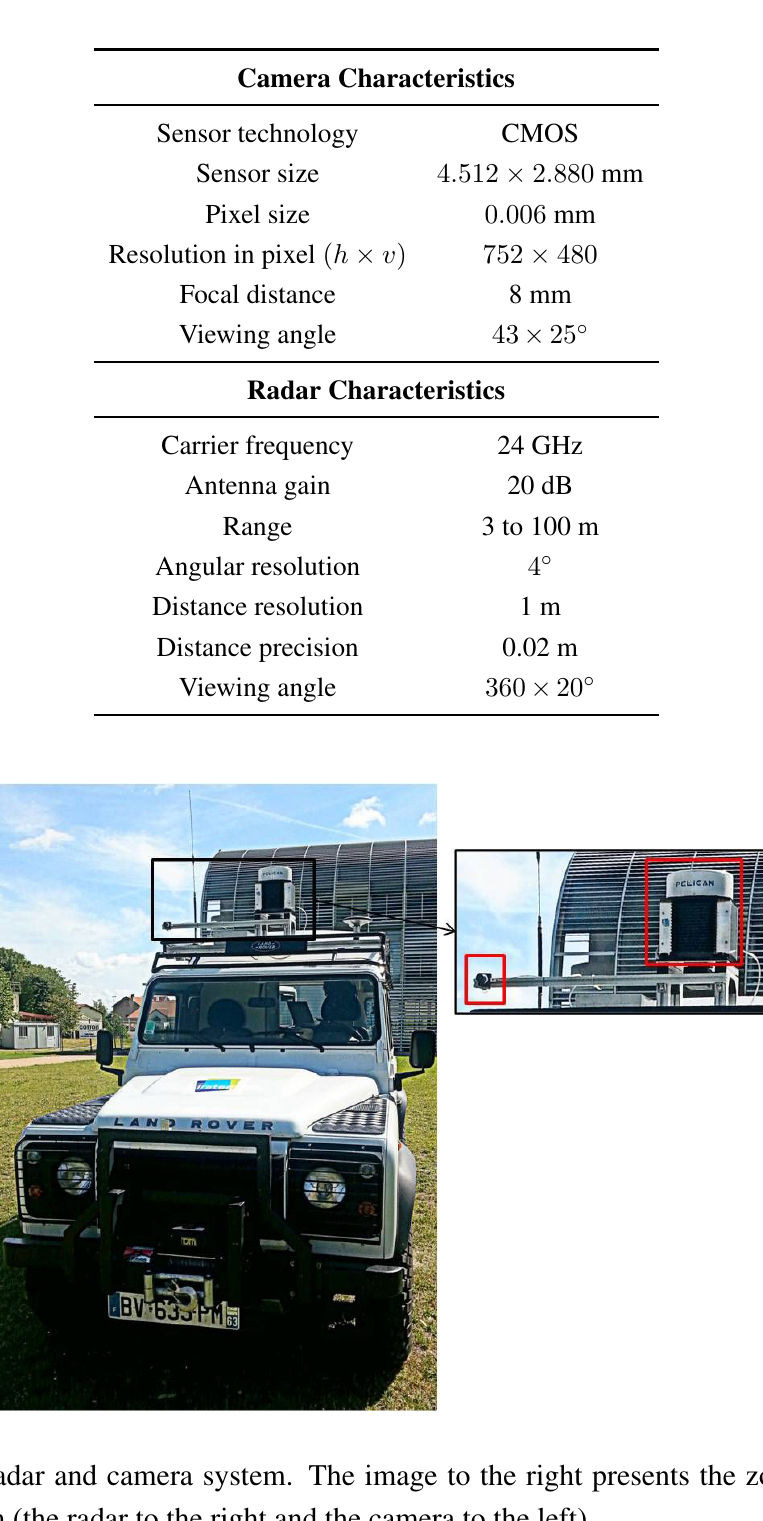
Table 1. Camera and radar characteristics.